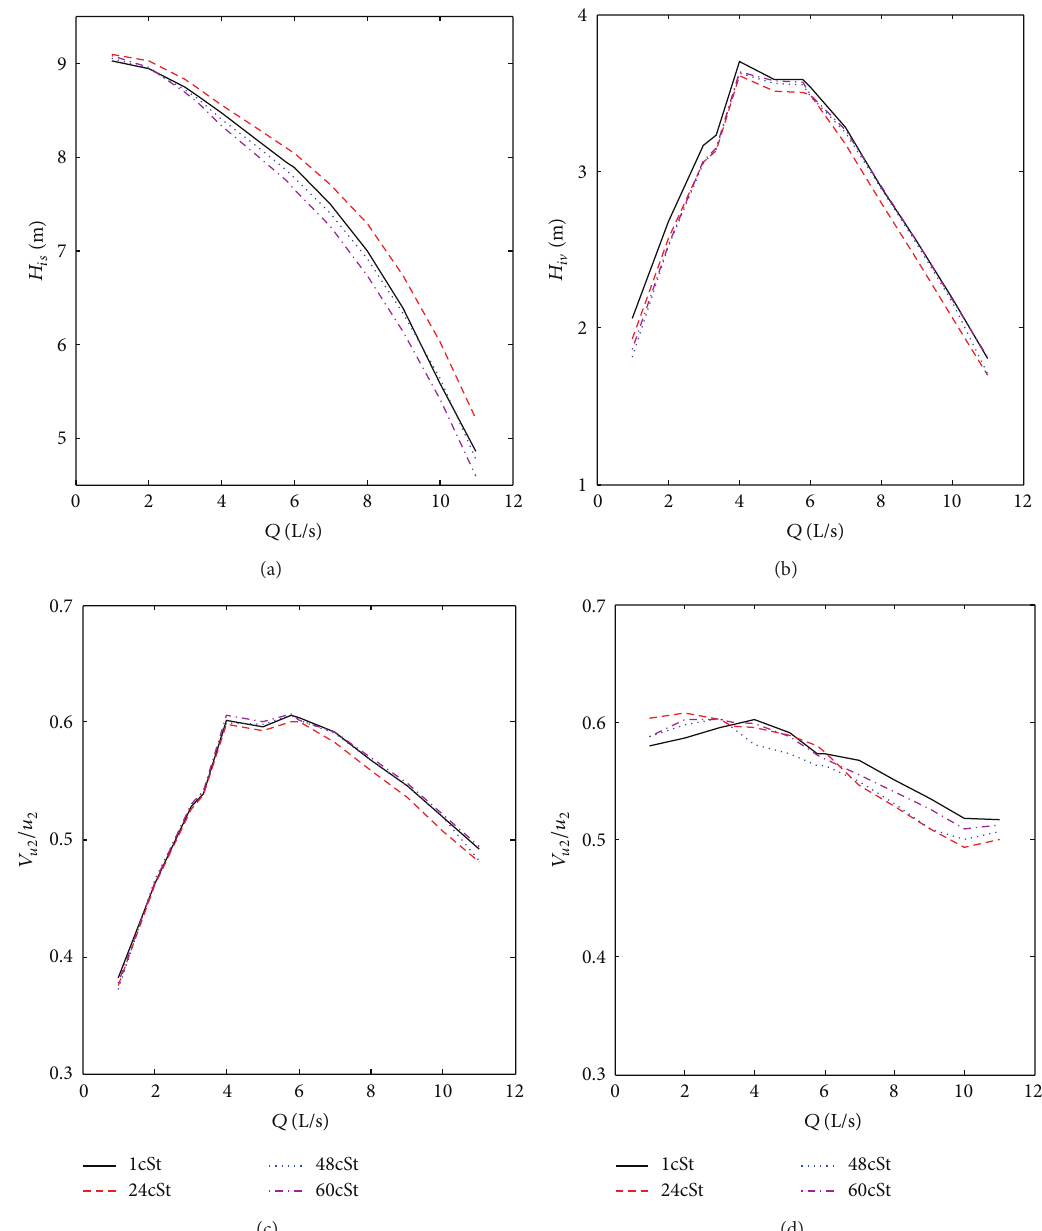
Figure 12: Impeller static pressure head and kinetic head rises, dimensionless tangential velocity of liquid at impeller exit at various liquid viscosities, and Ra = 50 𝜇 m, (a) static pressure head rise, (b) kinetic head rise, (c) tangential velocity with volute, and (d) tangential velocity without